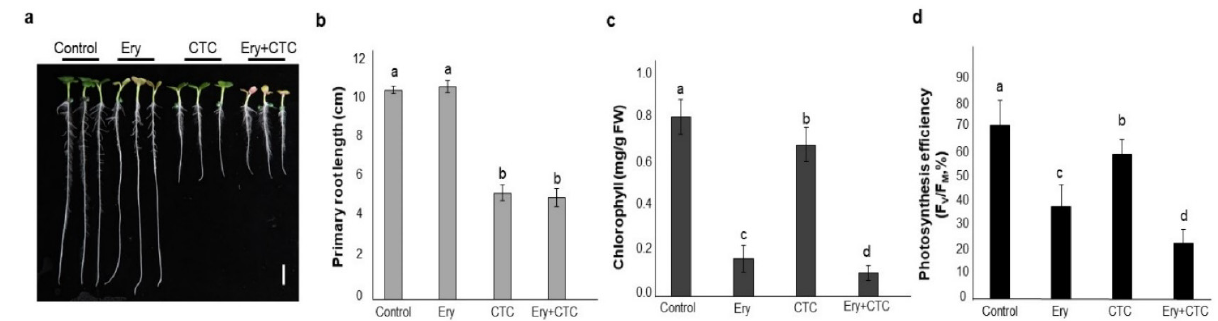
Figure 1. Growth of Brassica campestris seedlings treated with the veterinary antibiotics, erythromycin or chlortetracycline. Surface-sterilized seeds were placed on agar plates in the absence (control) or presence of erythromycin (Ery), chlortetracycline (CTC), or a combination of the two (Ery + CTC) and grown vertically for 5 days. ( a ) Morphological phenotypes at day 5. ( b ) Primary root length. Primary root length was measured from photographs using ImageJ software Data are means ± SD ( n = 39). ( c ) Total chlorophyll (Chl) content (Chl a +Chl b ). Chl was extracted from detached cotyledons using methanol. Data are means ± SD ( n = 39). ( d ) Photosynthetic efficiency (F v /F m ). Data are means ± SD ( n = 25). Photosynthetic efficiency in cotyledon leaves ( n = 25) was measured, using a photosynthesis yield analyzer (MINI-PAM-II). Different letters above bars indicate statistically significant difference within each treatment as determined by one-way analysis of variance (ANOVA) and Tukey’s honestly significant difference (HSD) test, p < 0.05. All the experiments used 5 mg/L of the indicated antibiotics and were replicated four times with similar results.